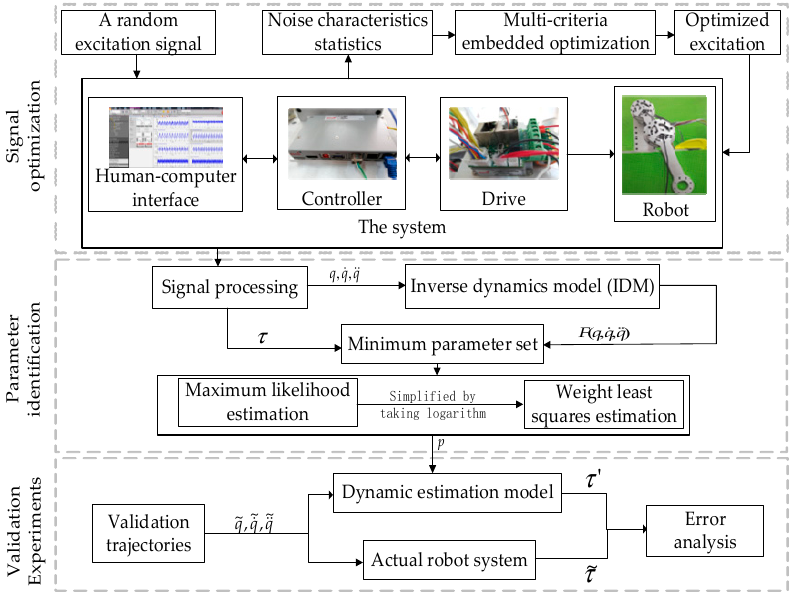
Figure 1. Overall procedure of parameter identification.